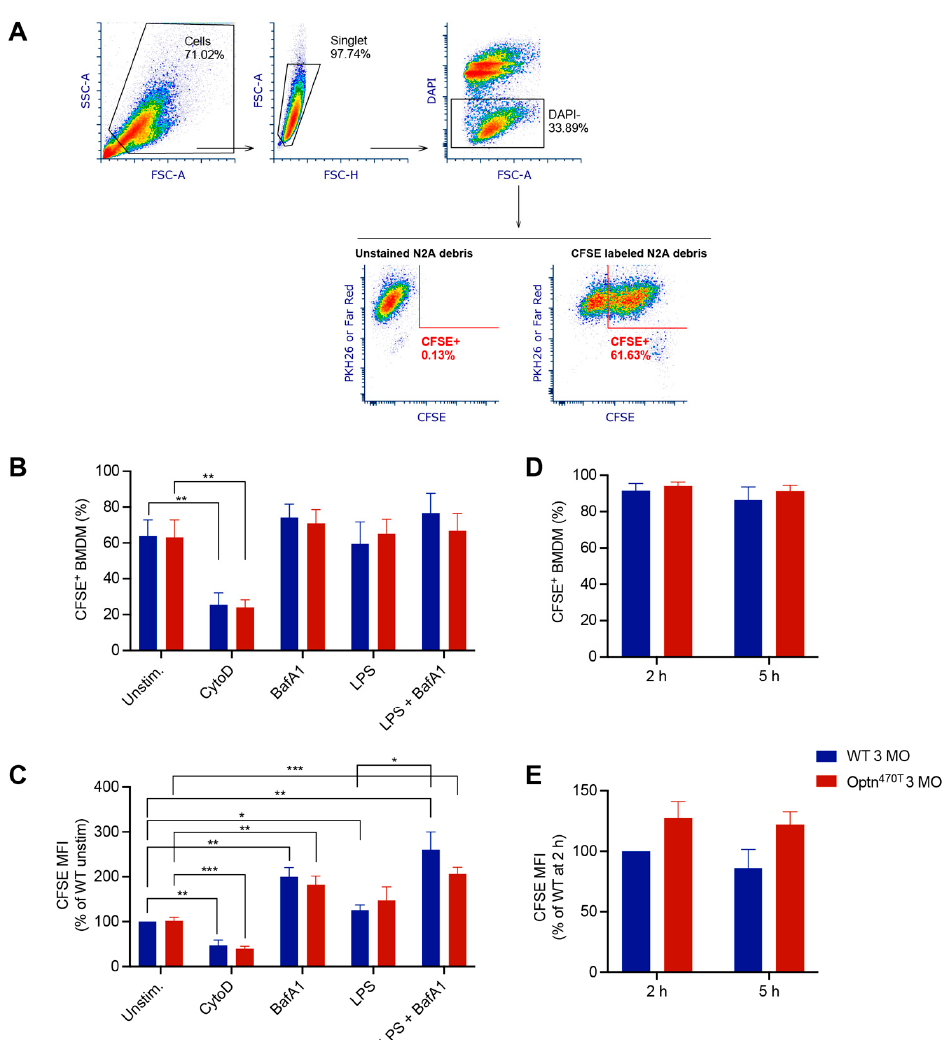
Figure 2. Optineurin insufficiency did not affect phagocytosis in young BMDMs. ( A ) Phagocytosis assay gating strategy: the main cell population was gated on FCS and SSC; cell aggregates were excluded by using FSC-A and FSC-H; live cells were gated as DAPI negative (remark: DAPI + events included unphagocytosed N2A debris); BMDMs or microglia were detected as PKH26 or Far Red positive; the percent of phagocytic cells and the amount of phagocytosed CFSE + N2A debris was quantified. ( B ) The percentage of phagocytic cells was determined for BMDMs from 3-month-old (3 MO) WT and Optn 470T mice that were incubated with CFSE-labelled N2A debris for 5 h. When indicated, BMDMs were pretreated with 2 µ M CytoD for 30 min, treated with 200 nM BafA1 for 4 h before collection, and pretreated with 500 ng/mL of LPS for 24 h. ( C ) The amount of phagocytosed material was detected as MFI (normalized to WT unstimulated cells). For B-C the data are shown as mean ± SEM of 4–5 independent experiments. ( D , E ) BMDMs were incubated with E. coli bioparticles for the indicated times. ( D ) The percentage of cells that phagocytosed E. coli bioparticles and ( E ) MFI of phagocytosed material (normalised to WT phagocytosis at 2 h) are depicted for three indi- vidual experiments. Statistical analysis was done by unpaired Student’s t -test; * p < 0.05, ** p < 0.01, *** p < 0.001. Having ruled out differences in the basal level of phagocytosis of apoptotic material between WT and Optn 470T BMDMs, we induced a proinflammatory phenotype by pre- treatment with LPS for 24 h before the addition of the N2A debris. LPS alone or in combi- nation with BafA1, compared to the corresponding untreated and BafA1 treated control BMDMs, did not modify the percentage of phagocytic WT and Optn 470T BMDMs (Figure 2B). However, LPS stimulation led to a small ~20–30% increase in MFI, reaching statistical significance for WT BMDMs, and showing a trend for Optn 470T BMDMs (Figure 2C). The combined treatment with LPS and BafA1 resulted in an approximately 2-fold increase in